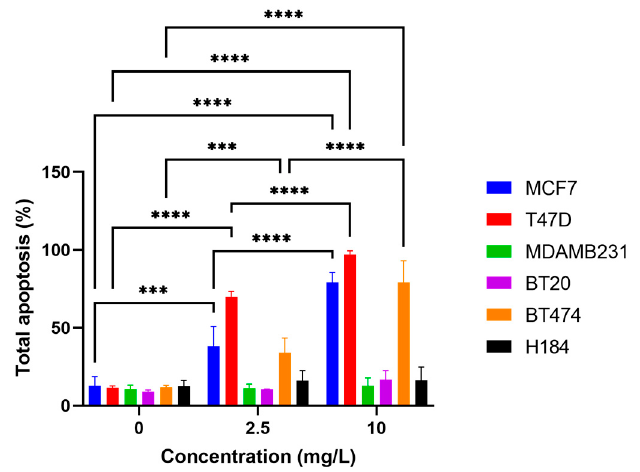
Figure A2. The cell viability of four breast cancer cell lines after 48 h and 72 h of specific GQD treatment. The data indicate averages from triplicates, and the error bars indicate SD. Significance is determined by using two-way ANOVA statistical analysis. The significant differences are indicated by using *. ***: p < 0.001, ****: p < 0.0001.